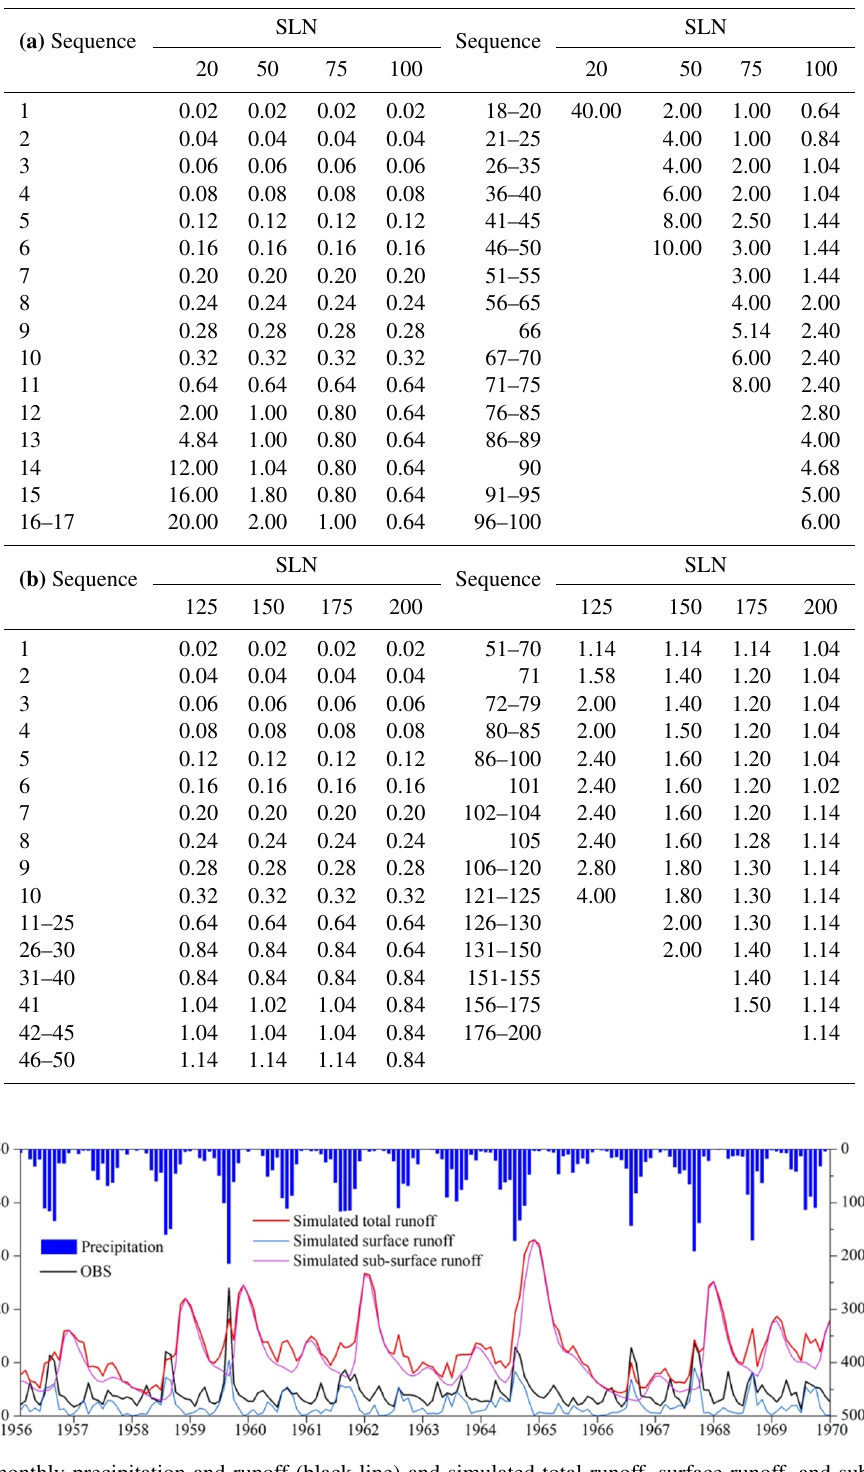
Table 1. (a) Thickness (m) of each soil layer for different SLNs (20, 50, 75, and 100). (b) Thickness (m) of each soil layer for different SLNs (125, 150, 175, and 200).